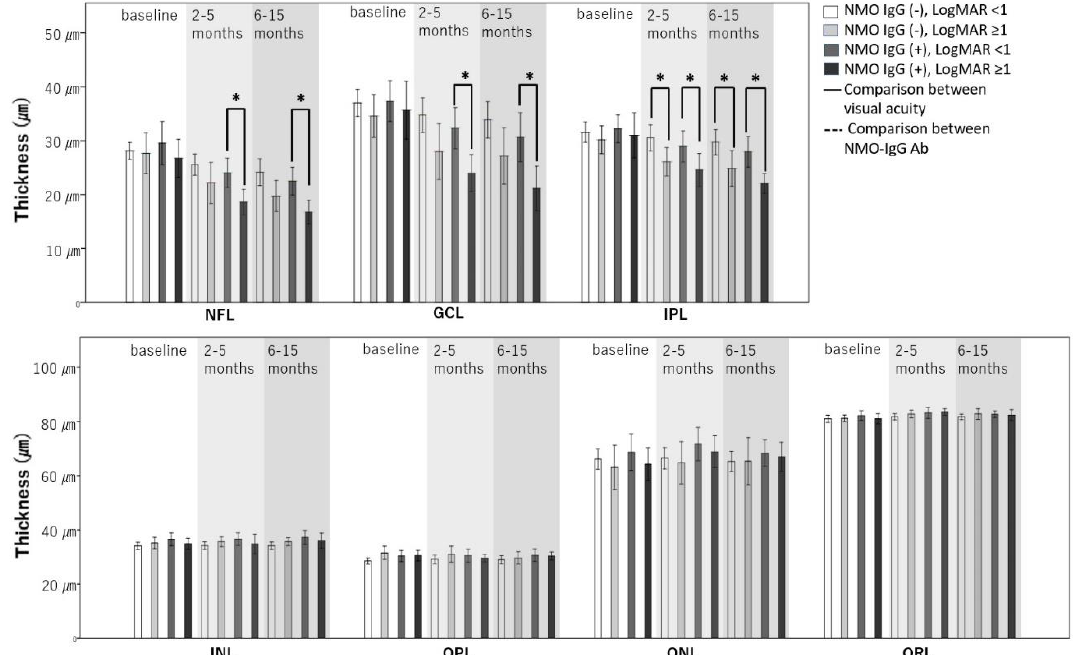
Figure 3. Changes in the thickness of each layer in the four groups over time. Interactions between time and group according to linear regression with GEE were significant at the p < 0.05 level; NFL p < 0.001; GCL p = 0.001; IPL p < 0.001; OPL p = 0.026; ONL p = 0.01. An asterisk (*) indicates a significant difference between the two groups.